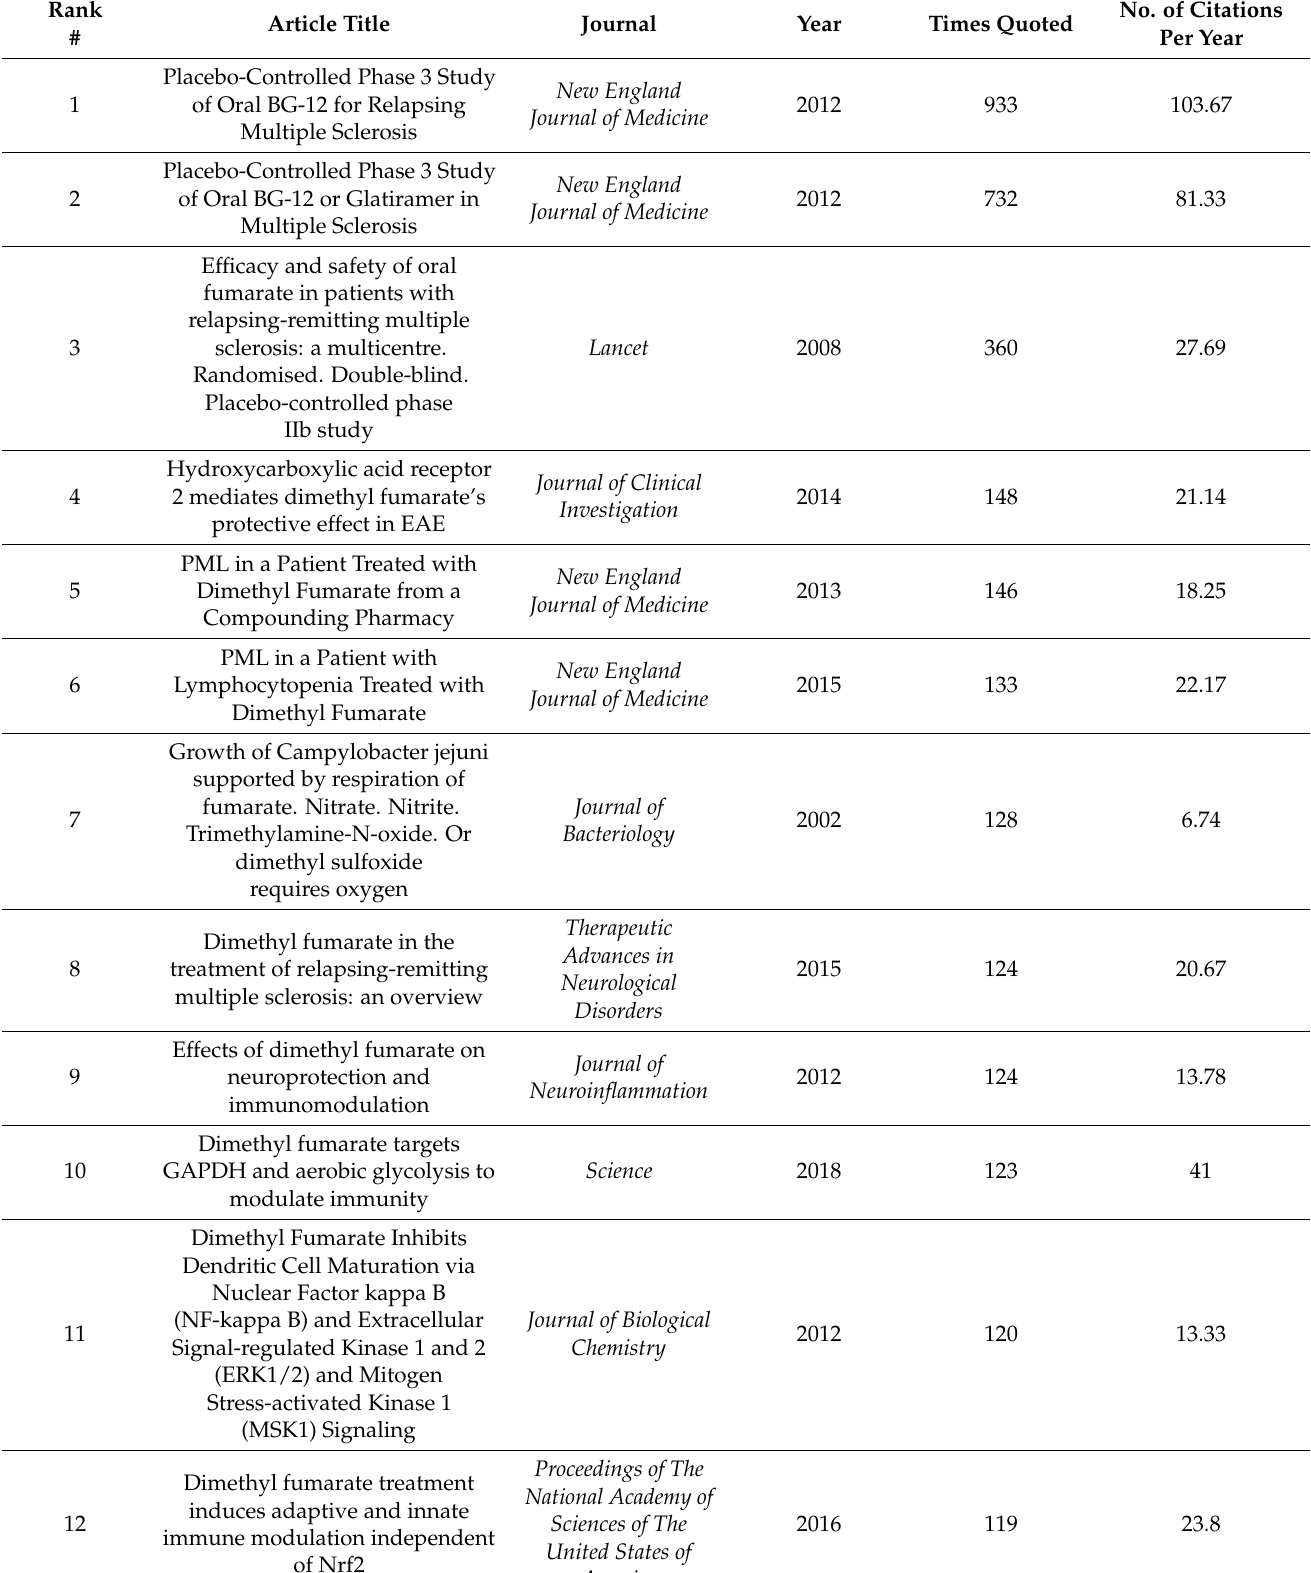
Table 1. Bibliometric information associated with the top 100 (T100) cited